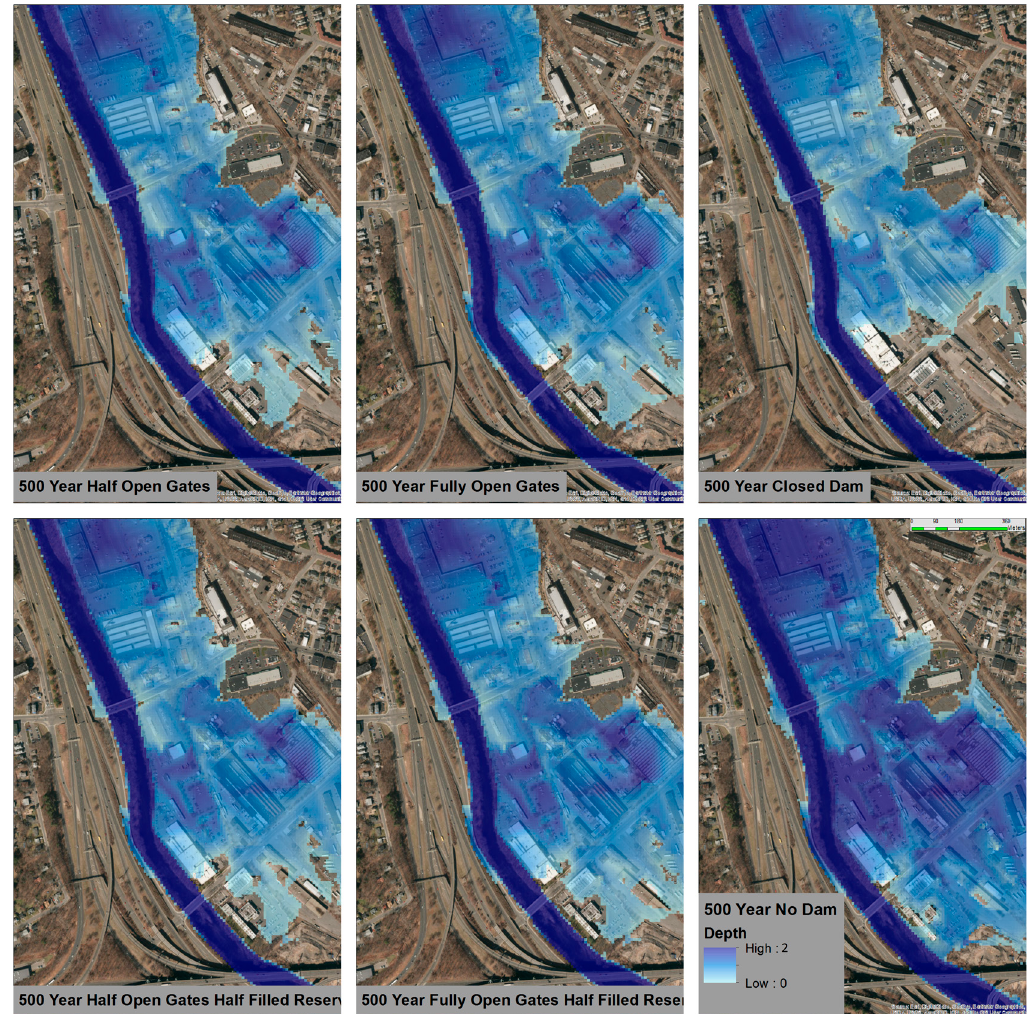
Figure 11. Simulated maximum 500-year flood inundation in various dam operation scenarios.